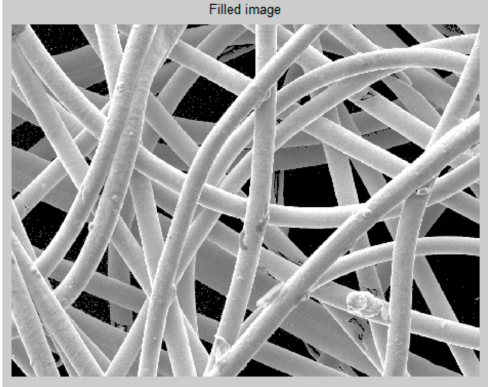
Figure 5. Filled image using a threshold to change the background